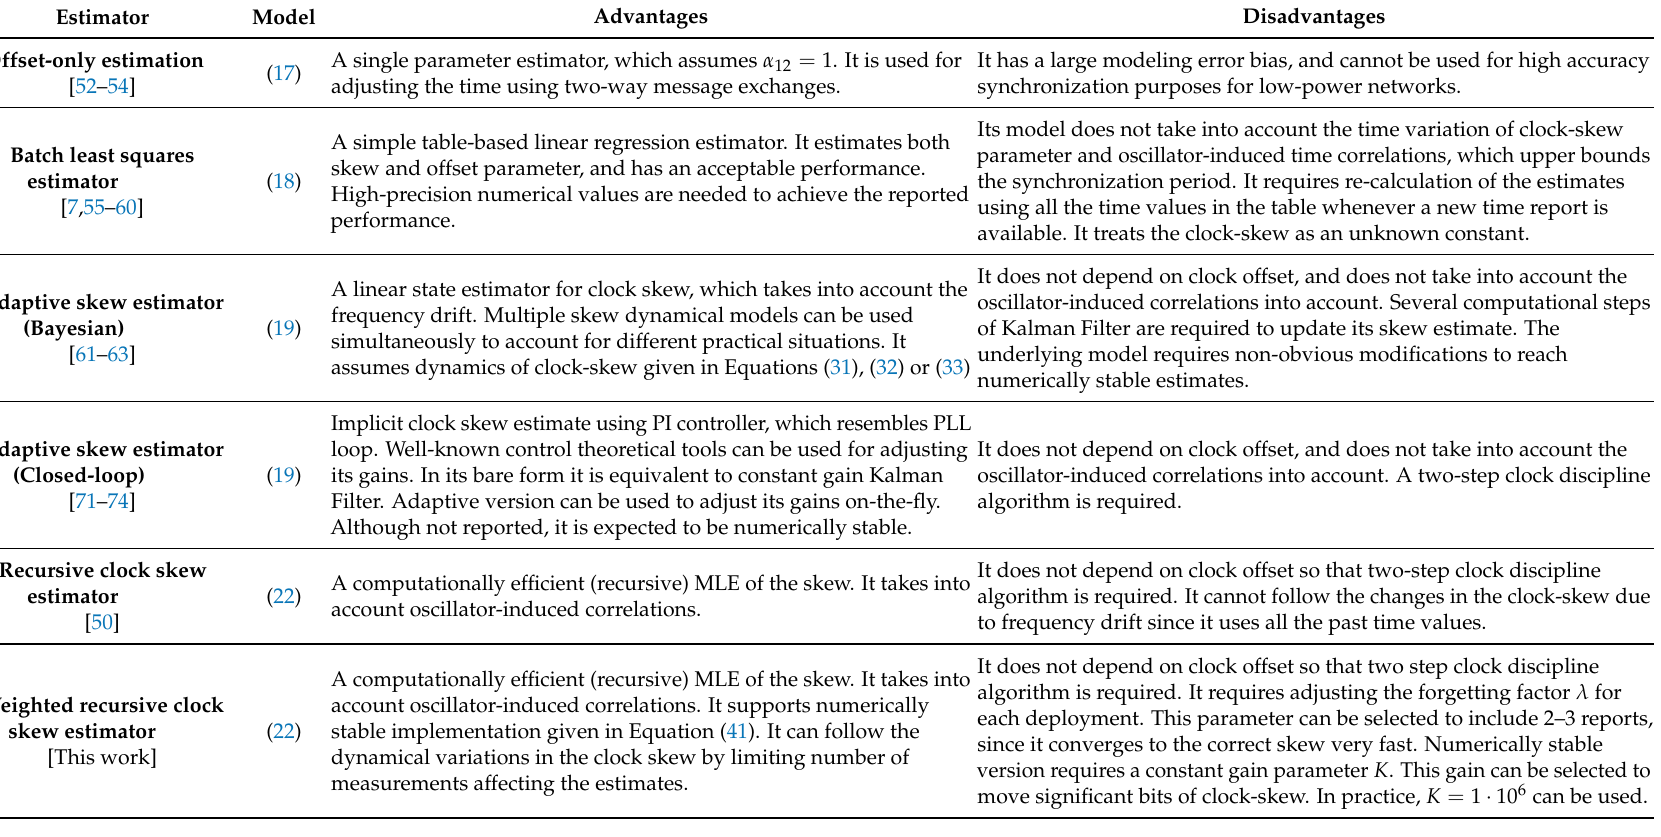
Table 6. Available clock discipline